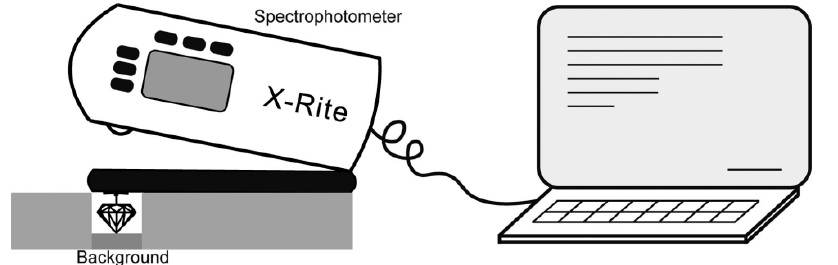
Figure 1. Some of tsavorite samples with various tones used in this study.